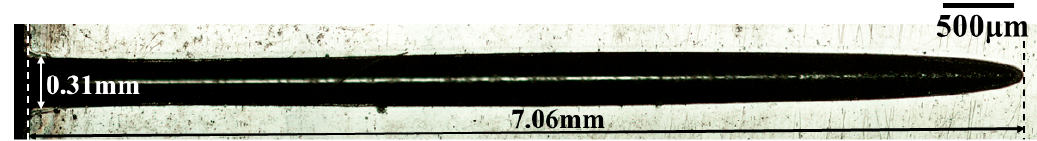
Figure 6. Sectional morphology of the hole with the maximum aspect ratio.